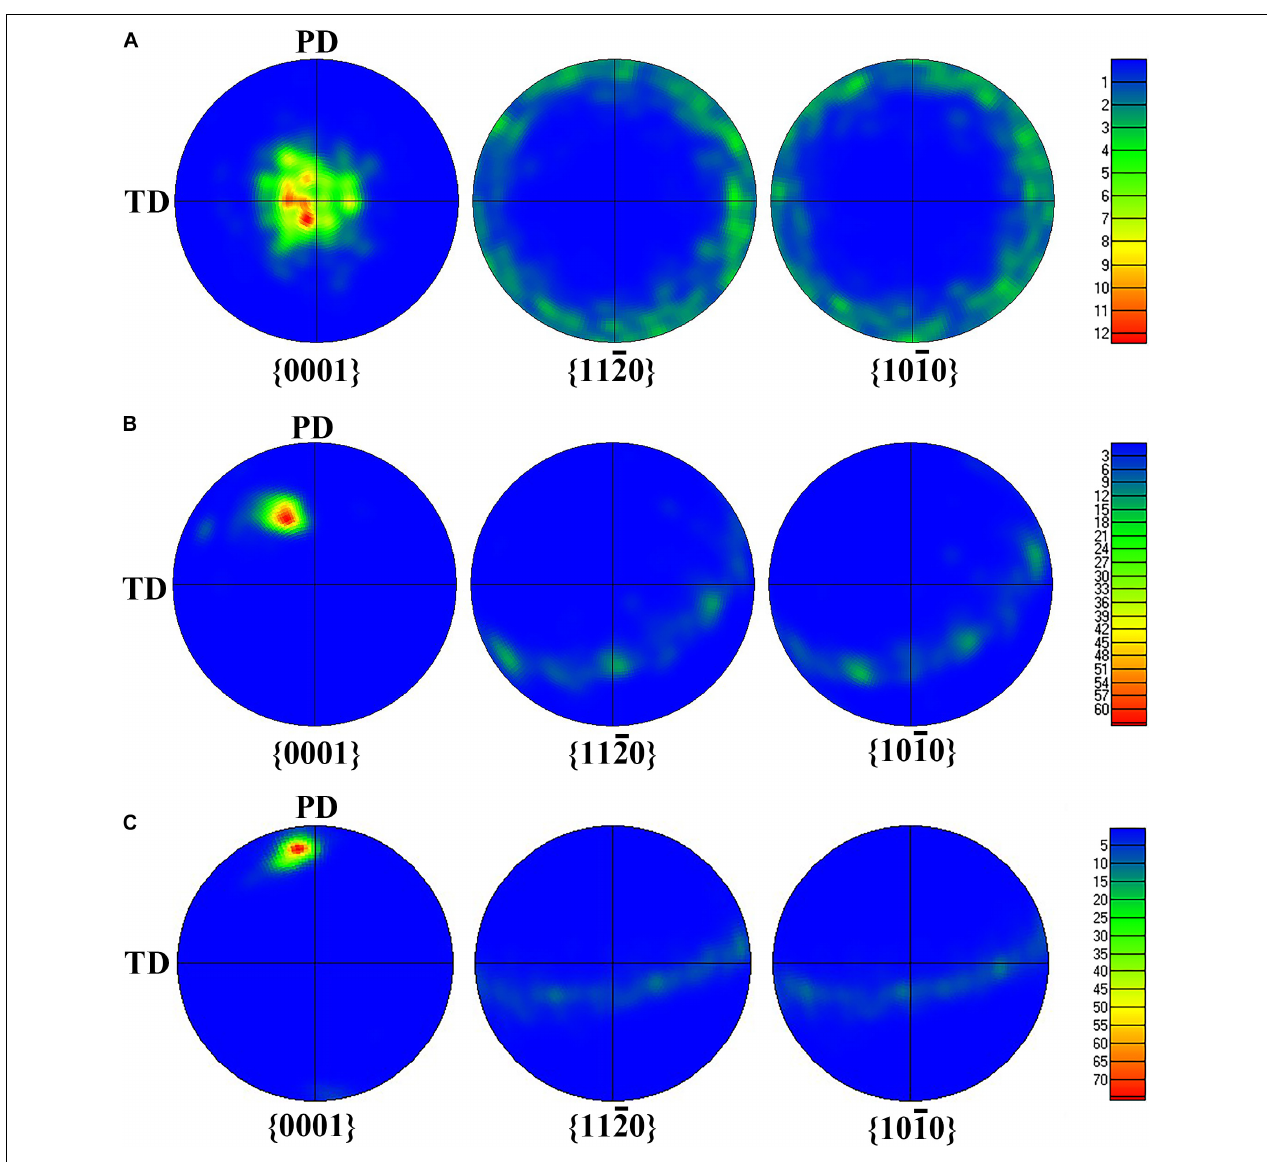
FIGURE 5 | The pole figure of {0001} plane: (A) BM, (B) FSP, (C) FSP-ZrO 2 .